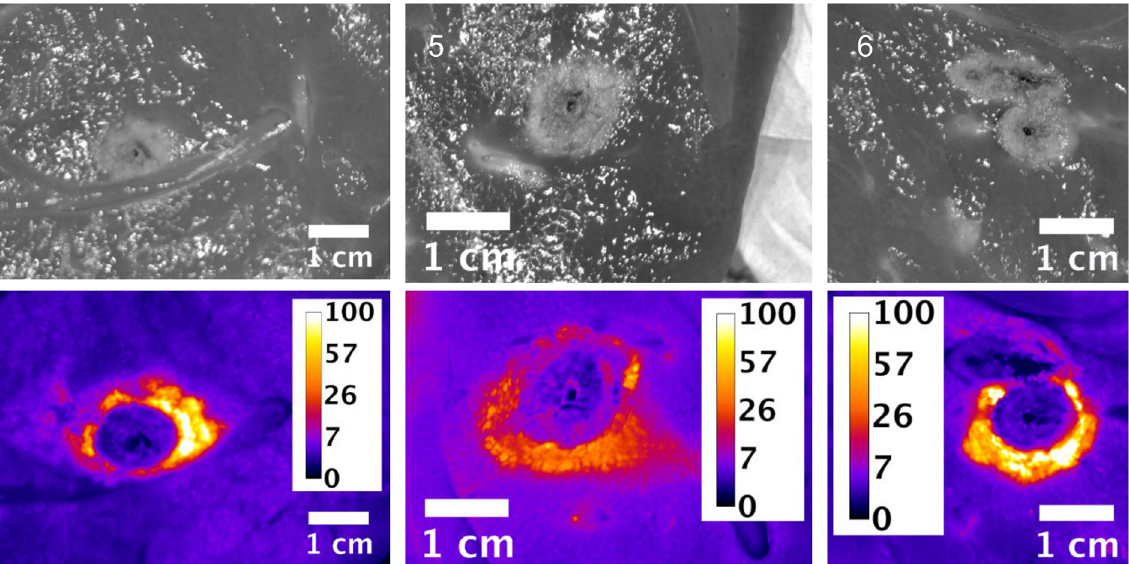
Fig 3. Plain and fluorescent images of ablation zone in pigs in Study B, group 1. Each pig received a single 12 minutes ablation and 3 minute cool down (total time = 15 minutes) with the Covidien device. Scale is μ g/g doxorubicin.